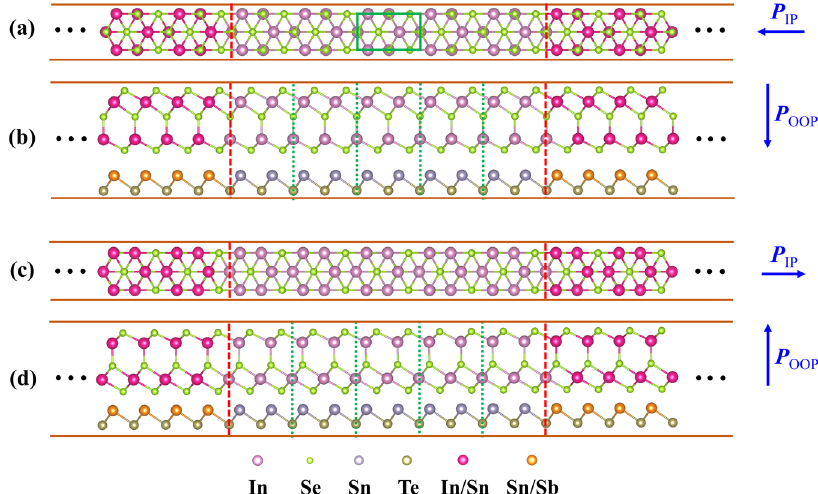
Fig. 3 Structural con fi gurations of the IP FTJ. The atomic structures of In 2 Se 3 /SnTe IP FTJs with N = 5 for the a , b P ↓ and c , d P ↑ states. a , c are the top views. b , d are the side views seen against a + b direction as de fi ned in Fig. 1a – c. Red vertical dashed lines represent the boundaries between electrodes and the barrier layers. The deep green rectangle indicates one orthorhombic cell (two times of the hexagonal unit cell in volume) of the In 2 Se 3 /SnTe barrier.